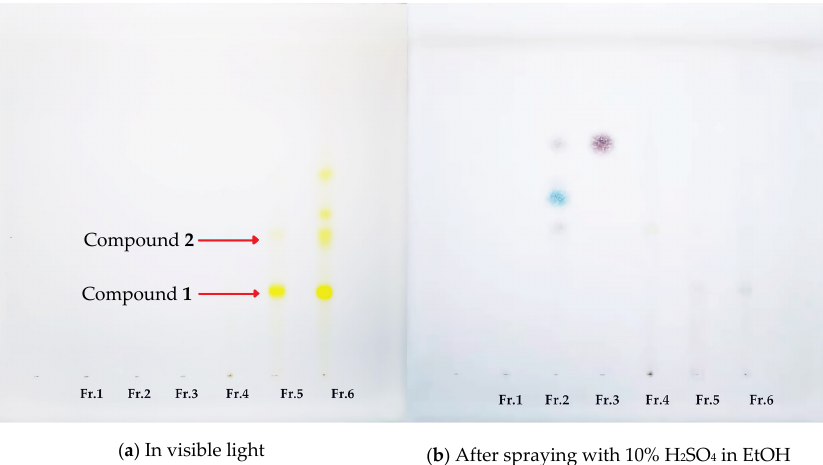
Figure 1. The TLC chromatograms of Fr.1 – Fr.6 eluted from macroporous resin column chromatography (Developing solvents: CHCl 3 -MeOH-HCOOH-H 2 O/5:2:0.5:0.5; sample volume: 10 μL; sample concentration: 2 mg/mL).